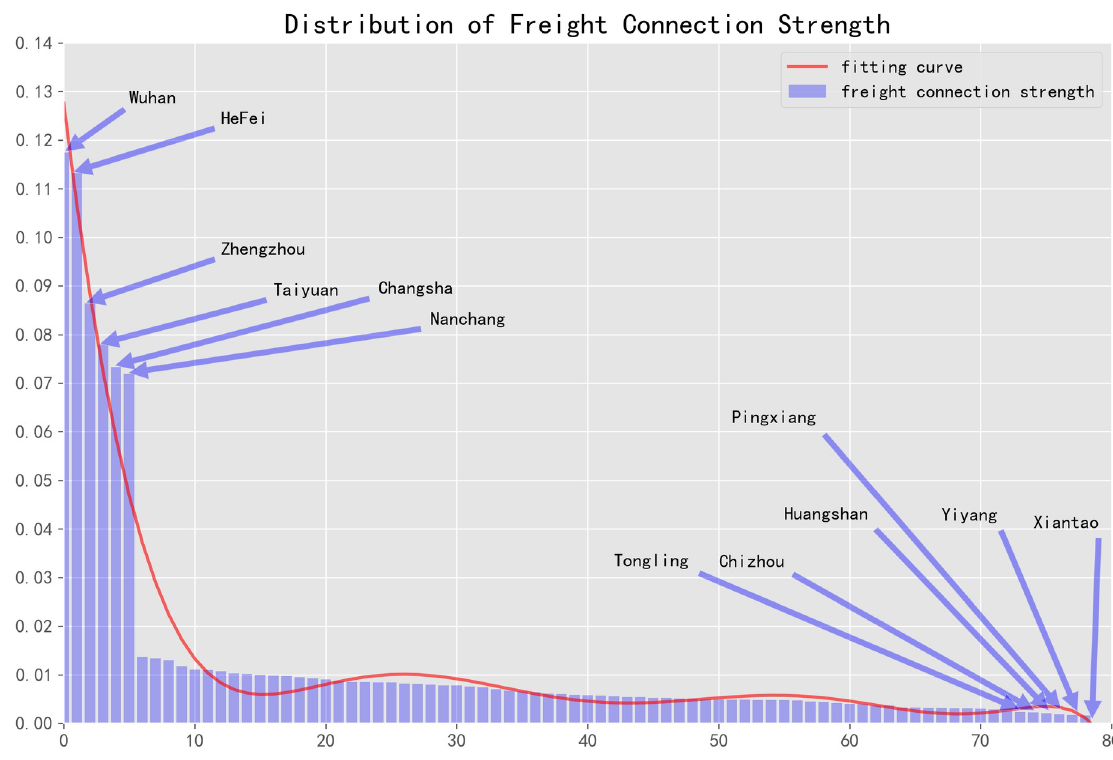
Fig 1. Distribution of the freight demand network strength among six provinces in central China during the spread of the epidemic.